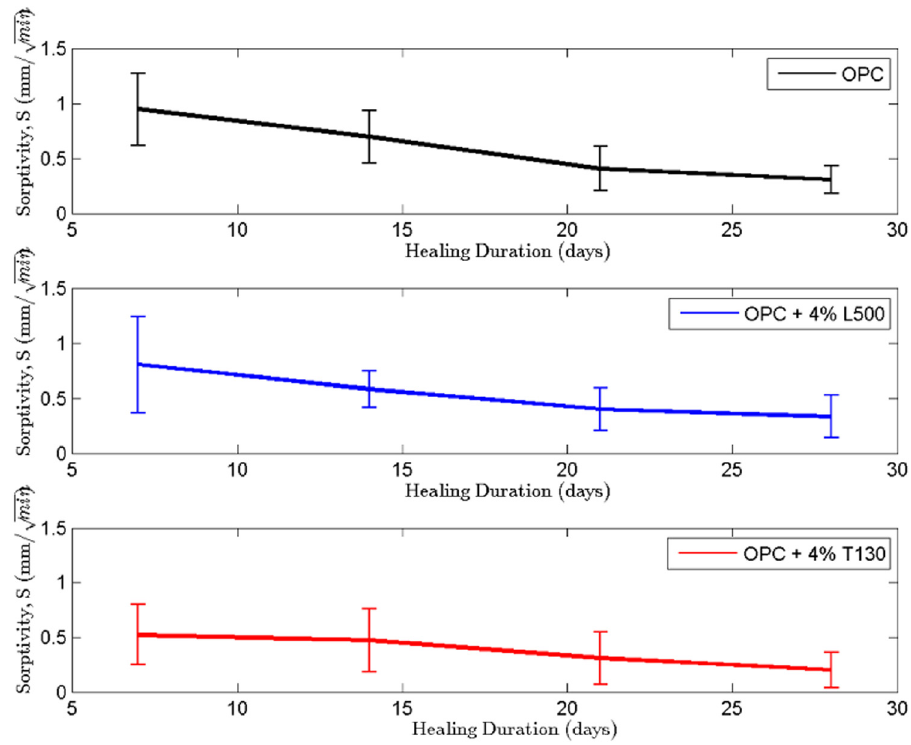
Figure 12: Sorptivity of cracked specimens containing L500 gelatin microcapsules ( blue line ) and T130 polyurea microcapsules ( red line ) at 4% volumetric fraction compared with cracked cement specimens ( black line ) [ 94 ]